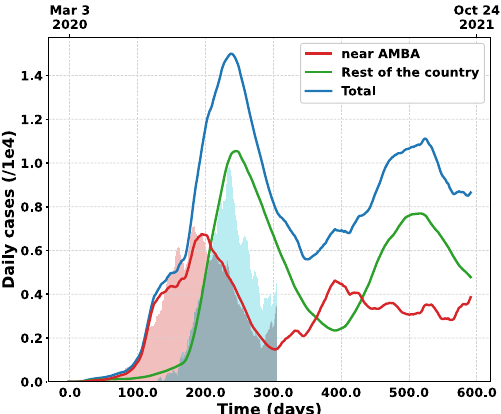
Figure 6. Prediction of the geographical evolution of the pandemic for p = 0.1 , α = 5 and the mobility of the Table 2. Three curves are shown: daily cases in Argentina, in the near AMBA region (city of Buenos Ares and the closest urban conglomerates, not the entire metropolitan area) and in the rest of the country. The bars shaded in red and green represent the official daily cases obtained from the Ministry of Health of Argentina 28 for both geographic areas. The model shows a 50-day delay between the peak in the near-AMBA region and the rest of the country. This fact prevents the complete suppression of the